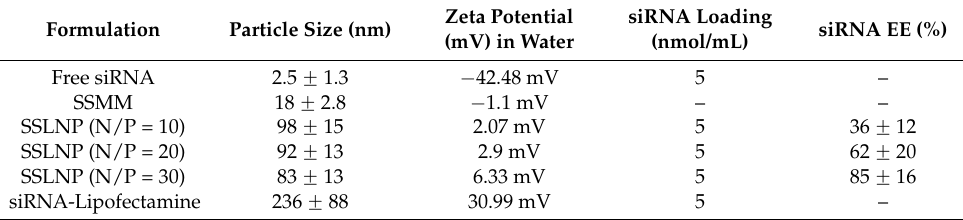
Values are mean ˘ SD. EE: encapsulation efficiency.